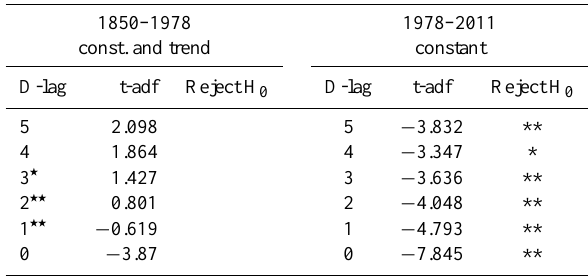
Table 1. ADF unit-root tests on 1 rfCO 2 . Table 2. ADF Unit-root Tests on 1 rfN 2 O.